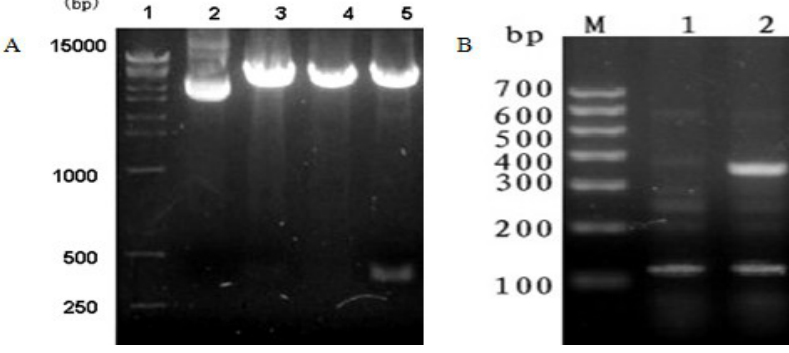
Figure 1. Restriction enzyme digestion analysis of pcDNA3.1(+)/mBD1-mBD3 and